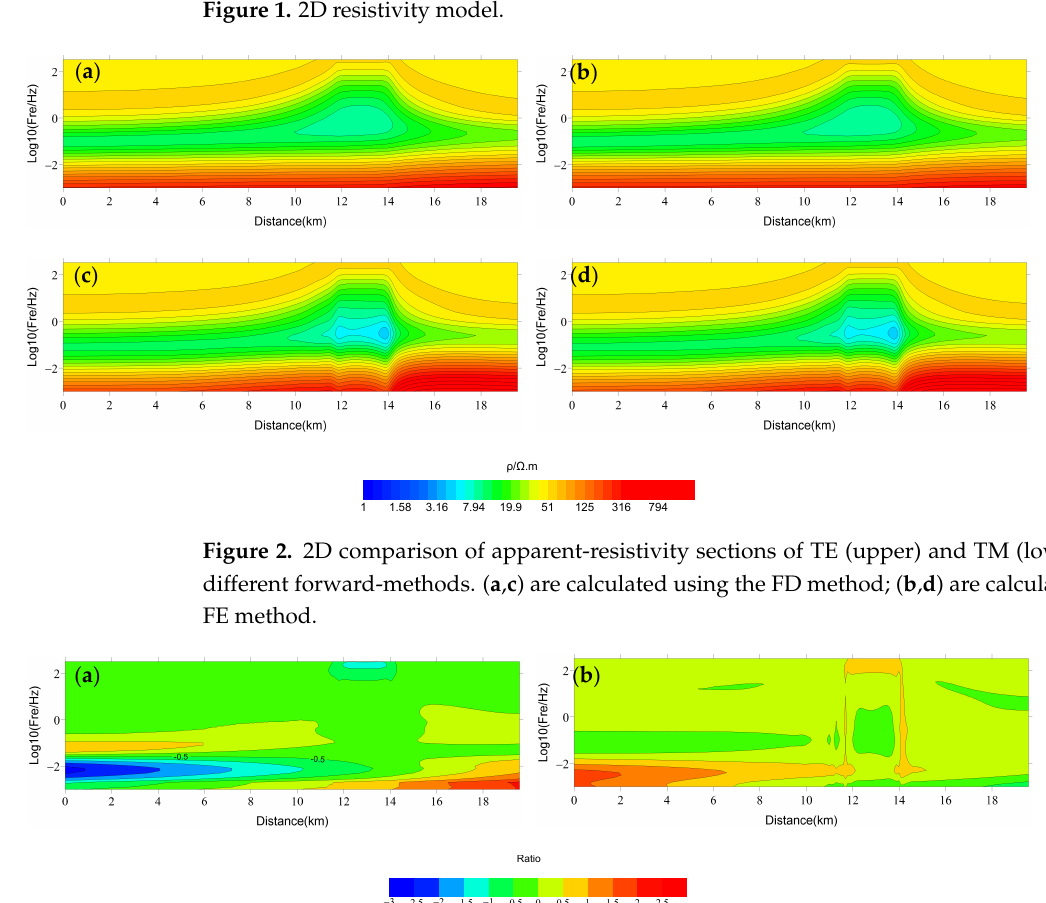
Figure 3. Relative error percentage of apparent resistivity between 2D FD and FE forward method. TE mode ( a ); TM mode ( b ).